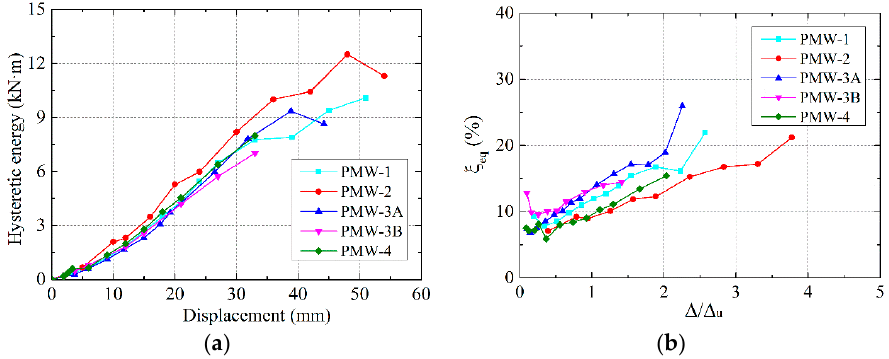
Figure 14. Evaluation of energy dissipation: ( a ) Dissipated energy of the specimens; ( b ) the equivalent viscous damping ratio.